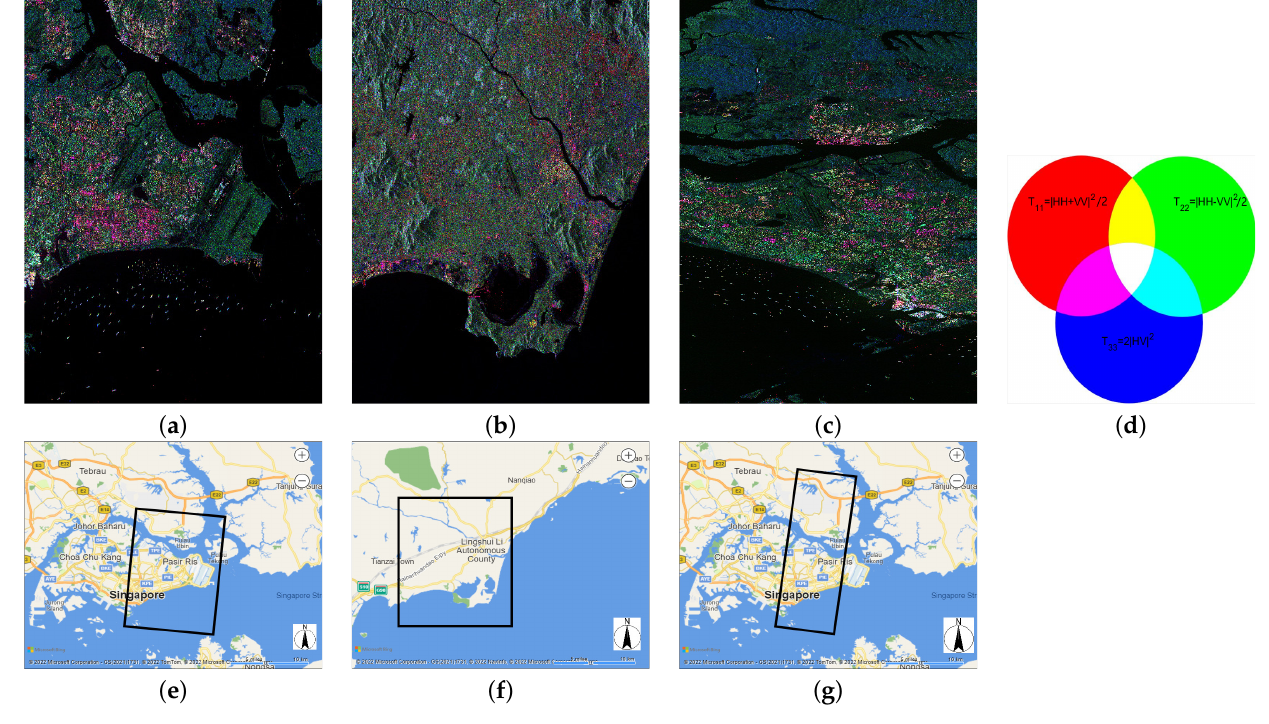
Figure 7. The Pauli pseudocolor images of the three experimental datasets: ( a ) data of Singapore from RADARSAT-2; ( b ) data of Lingshui fromf RADARSAT-2; ( c ) data of Singapore from TerraSAR-X. ( d ) The color code of the Pauli image, where ( T 11 , T 22 , T 33 ) are the diagonal of the coherent matrix, and ( HH , VV , HV ) are the three components of the Sinclair matrix. ( e ) Legend of data 1. ( f ) Legend of data 2. ( g ) Legend of data